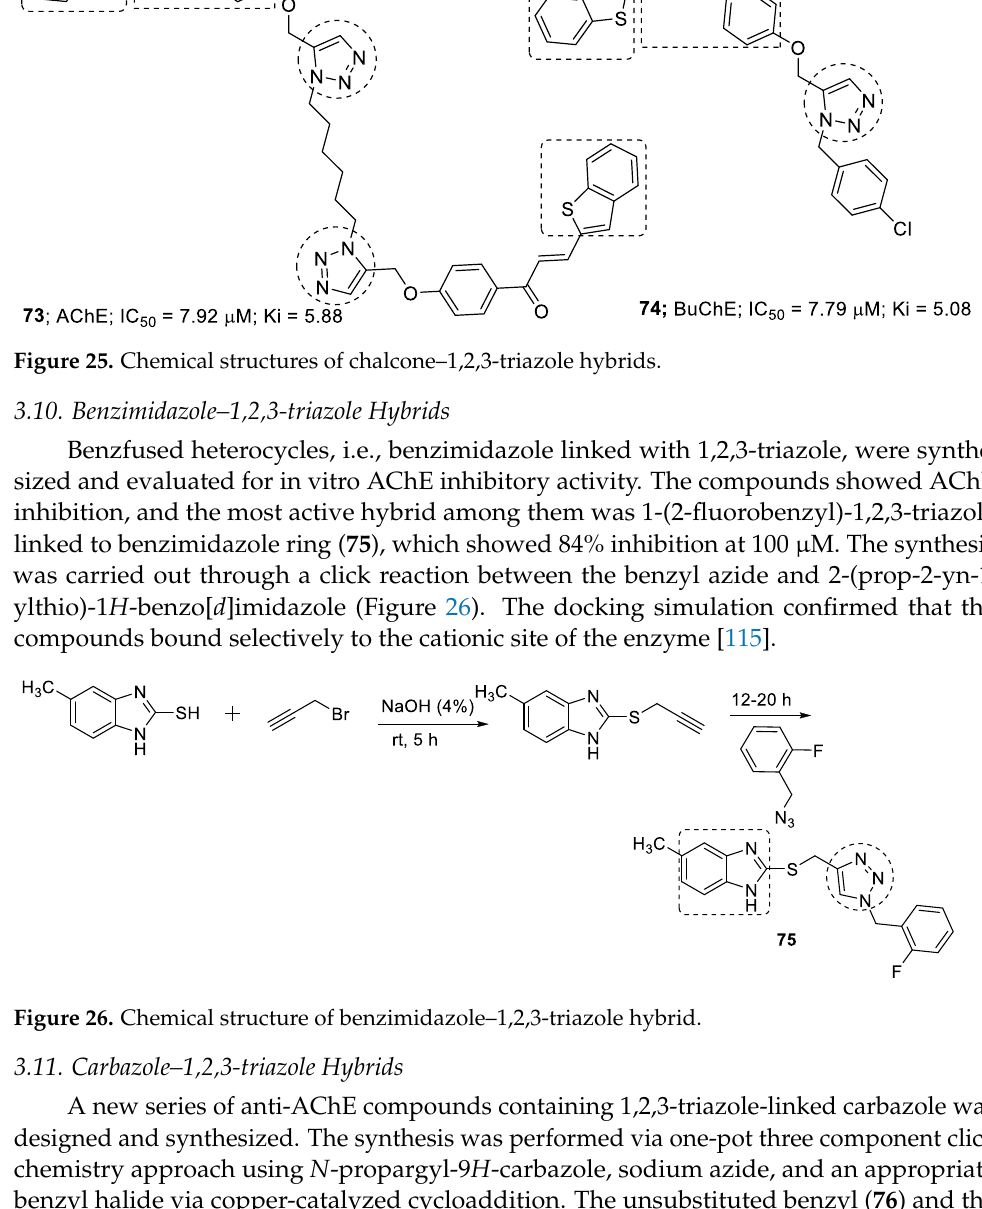
Figure 27. Chemical structures of carbazole-1,2,3-triazole hybrids. 3.12. 1,4-Naphthoquinone – 1,2,3-Triazole Hybrids The potential target for AD, i.e., AChE and BuChE, led Hosseini et al. to design and synthesize 1,4-naphthoquinone with 1,2,3-triazole acetamide derivatives. The anti-ChE activity and molecular docking confirmed that compound 82 possessed the strongest in- hibition against both AChE and BuChE, with K i values of 10.16 and 8.04 nM, taking ta- crine as a positive control with K i = 70.61 and 64.18 nM (Figure 28). Compound 82 binds to both the active sites of AChE and BuChE [117].